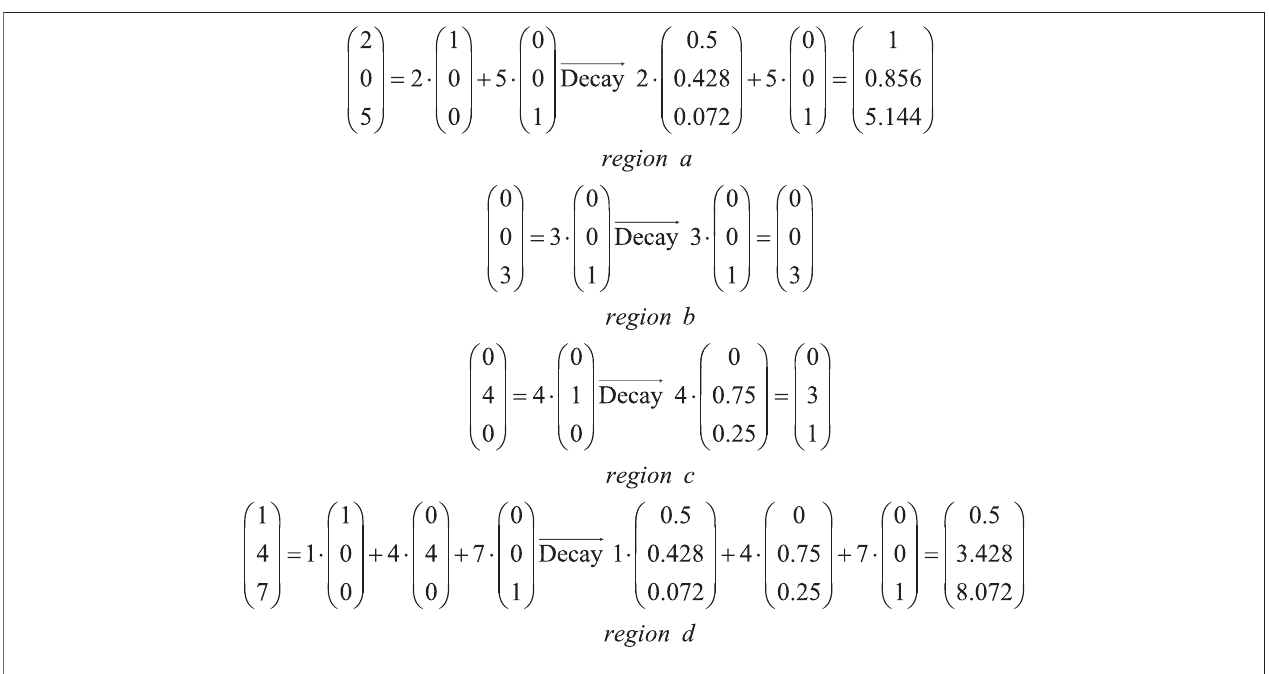
FIGURE 3 | Solution process for calculating the nuclide concentrations in four